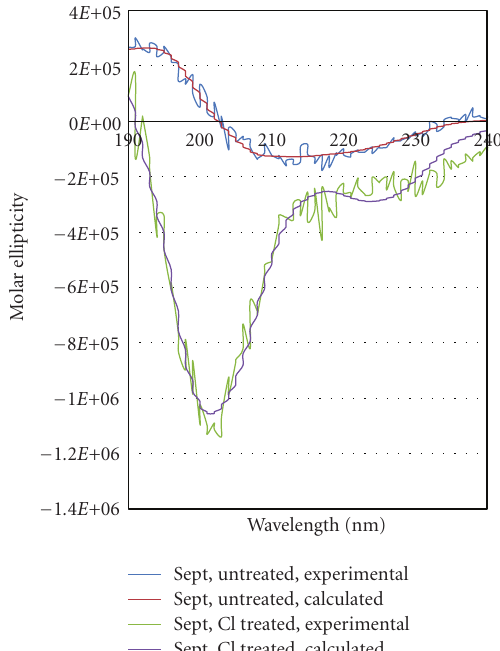
Figure 1: Overlay of the circular dichroism spectra for untreated (blue = experimental, red = curve fit) and chlorine-treated (green = experimental, purple = curve fit) SEB (2 μ g/mL). The initial free chlorine concentration for the treated sample was 1mg/L. Each circular dichroism spectrum is the average of 100 blank-subtracted